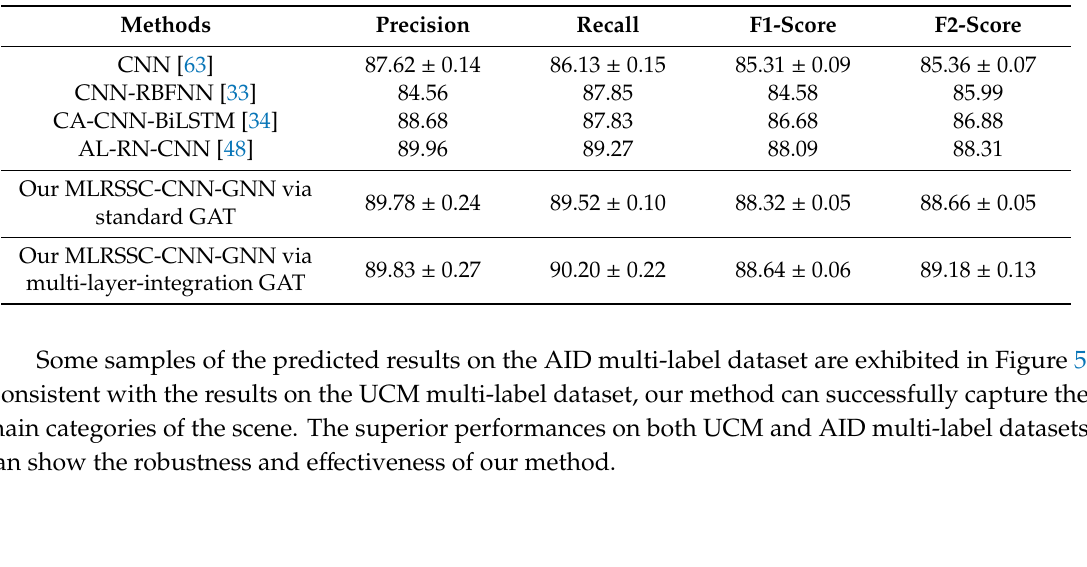
Table 2. Performances of di ff erent methods on the AID multi-label dataset (%).